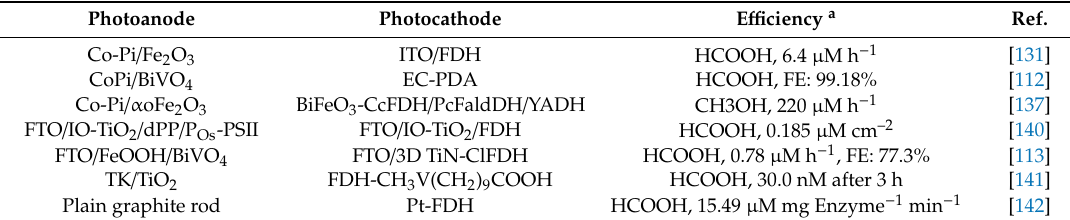
Figure 9. Schematic representation of the semi-artificial photosynthetic tandem PEC cell coupling CO 2 reduction to water oxidation. A blend of P Os and PSII adsorbed on a dpp-sensitized photoanode (IO-TiO 2 | dpp | P Os -PSII) is wired to an IO-TiO 2 | FDH cathode [140]. Table 3 . Performance comparison of different coupled photoelectrocatalytic/enzymatic CO 2 reduction systems.